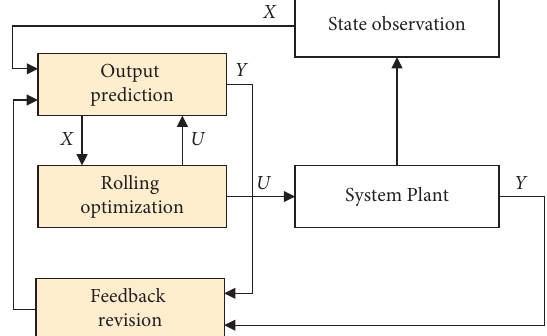
Figure 9: The structure of MPC control